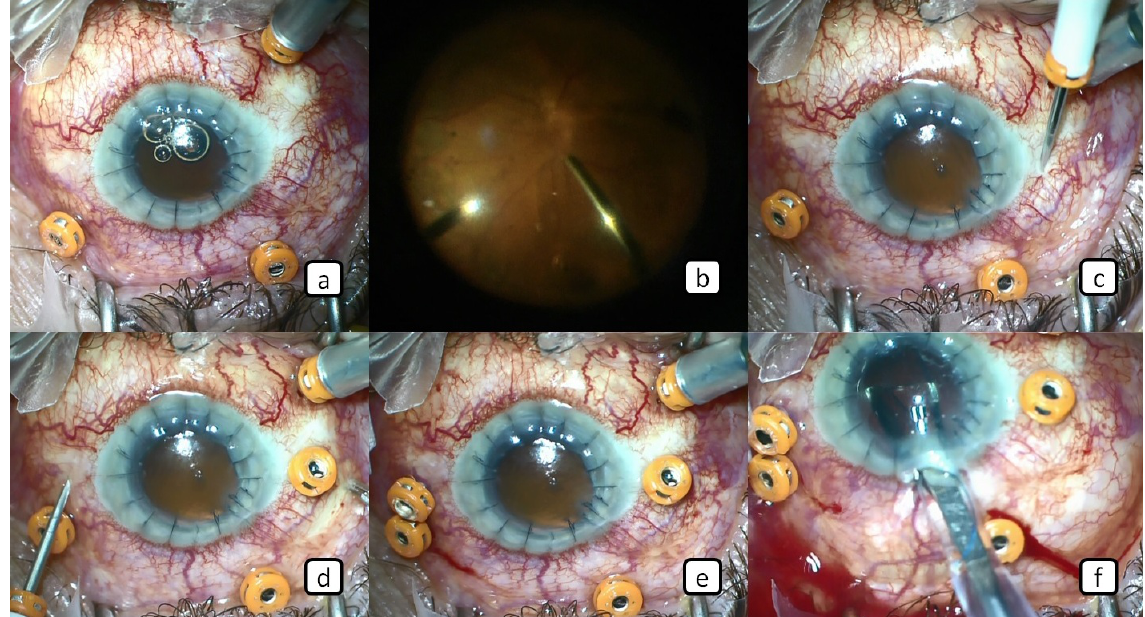
Figure 1: a) Three trocars are applied using a 23-gauge vitreoretinal trocar system for routine vitreoretinal procedure. b) The perfluorooactane is given. c-e) Two 3-mm scleral tunnels are created 2 mm away from and parallel to the limbus with the 23-gauge vitrectomy trocars at the 3 o’clock and 9 o’clock meridians. f) The 3-piece of foldable IOL is delivered to the anterior chamber.